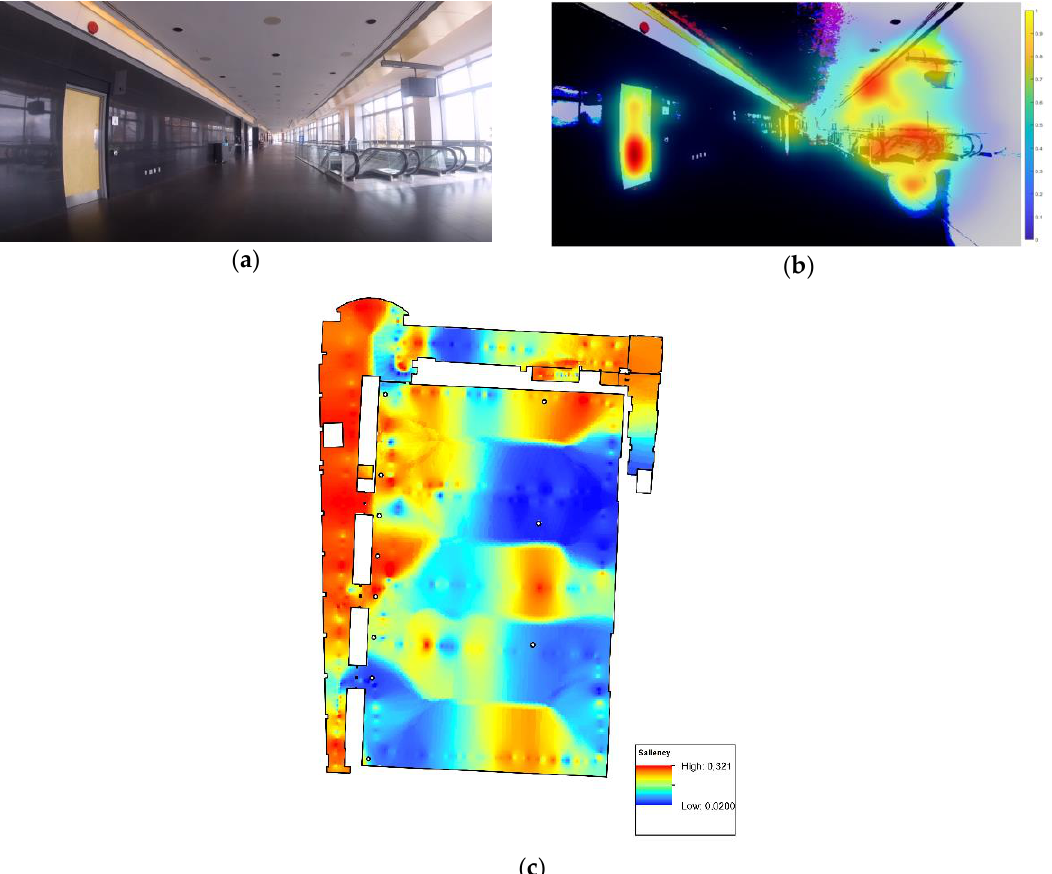
Figure 12. Mapping of saliency of scenes, ( a ) a frame of a geo-tagged video for a given wheelchair’s